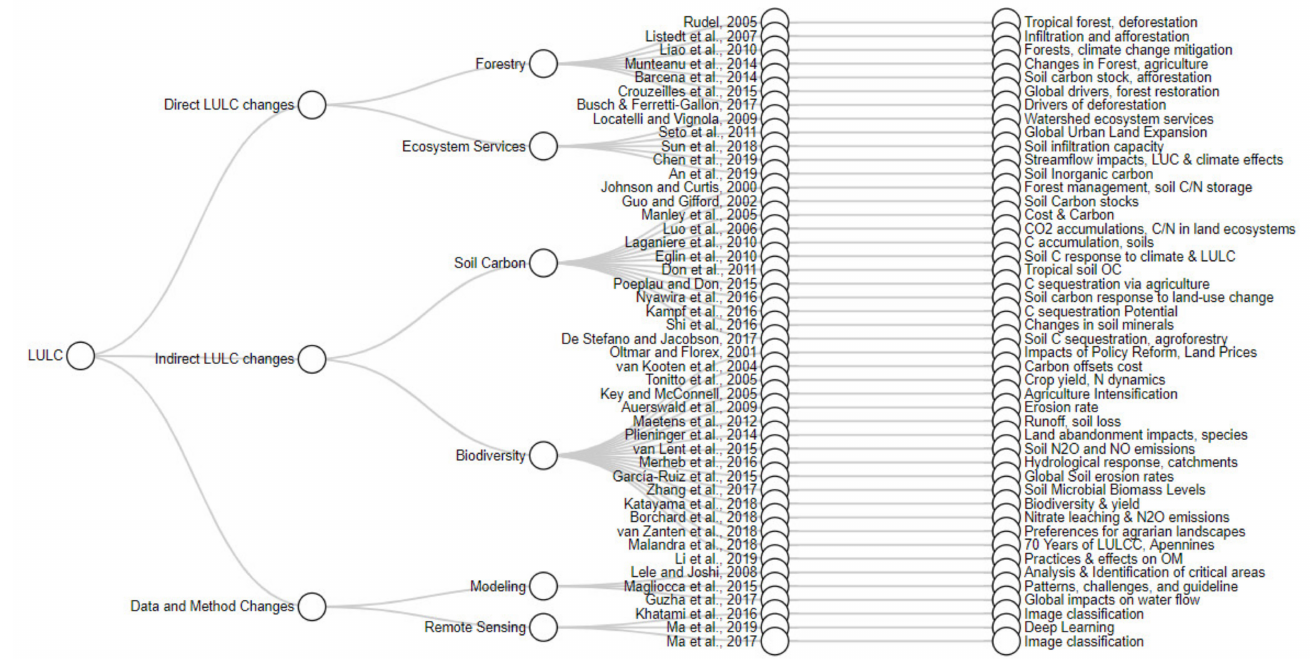
Figure 2. Diagram showing meta-studies divided based on